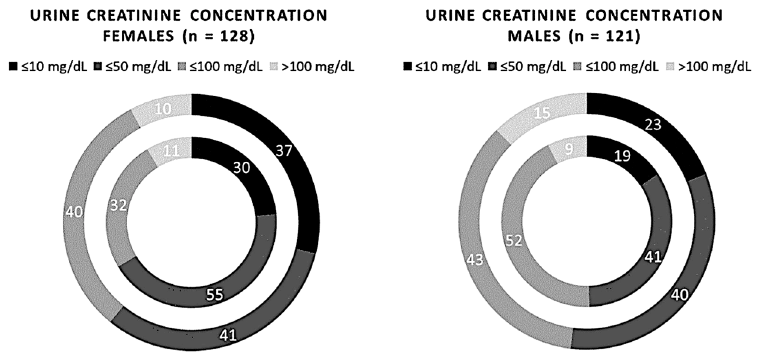
Figure 7. Comparison of 249 samples of creatinuria measured using the semi-quantitative and quantitative methods, redistributed on sex. The inner circle represents the Cobas C 501 assay results, and the outer circle indicates the results of the Sysmex UC 3500.